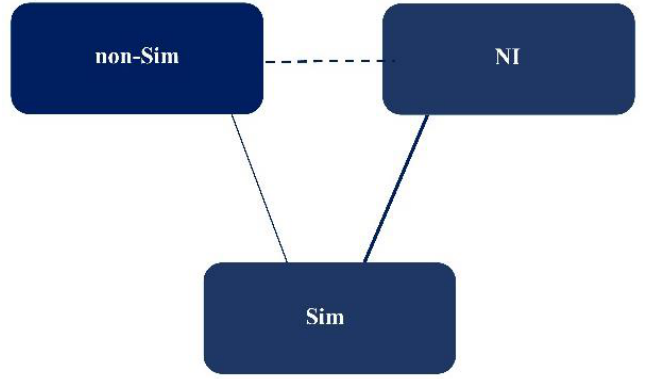
Figure 2. A network map showing the overview of the network meta-analysis performed in this study. The number of studies included in this analysis is indicated by the solid line (the number of studies is indicated by the thickness of the line). Dashed lines indicate relationships for which no randomized controlled trials (RCTs) were available, but for which indirect comparisons were attempted; Sim, simulation-based training; non-Sim, non-simulation-based training; NI, no educational intervention.